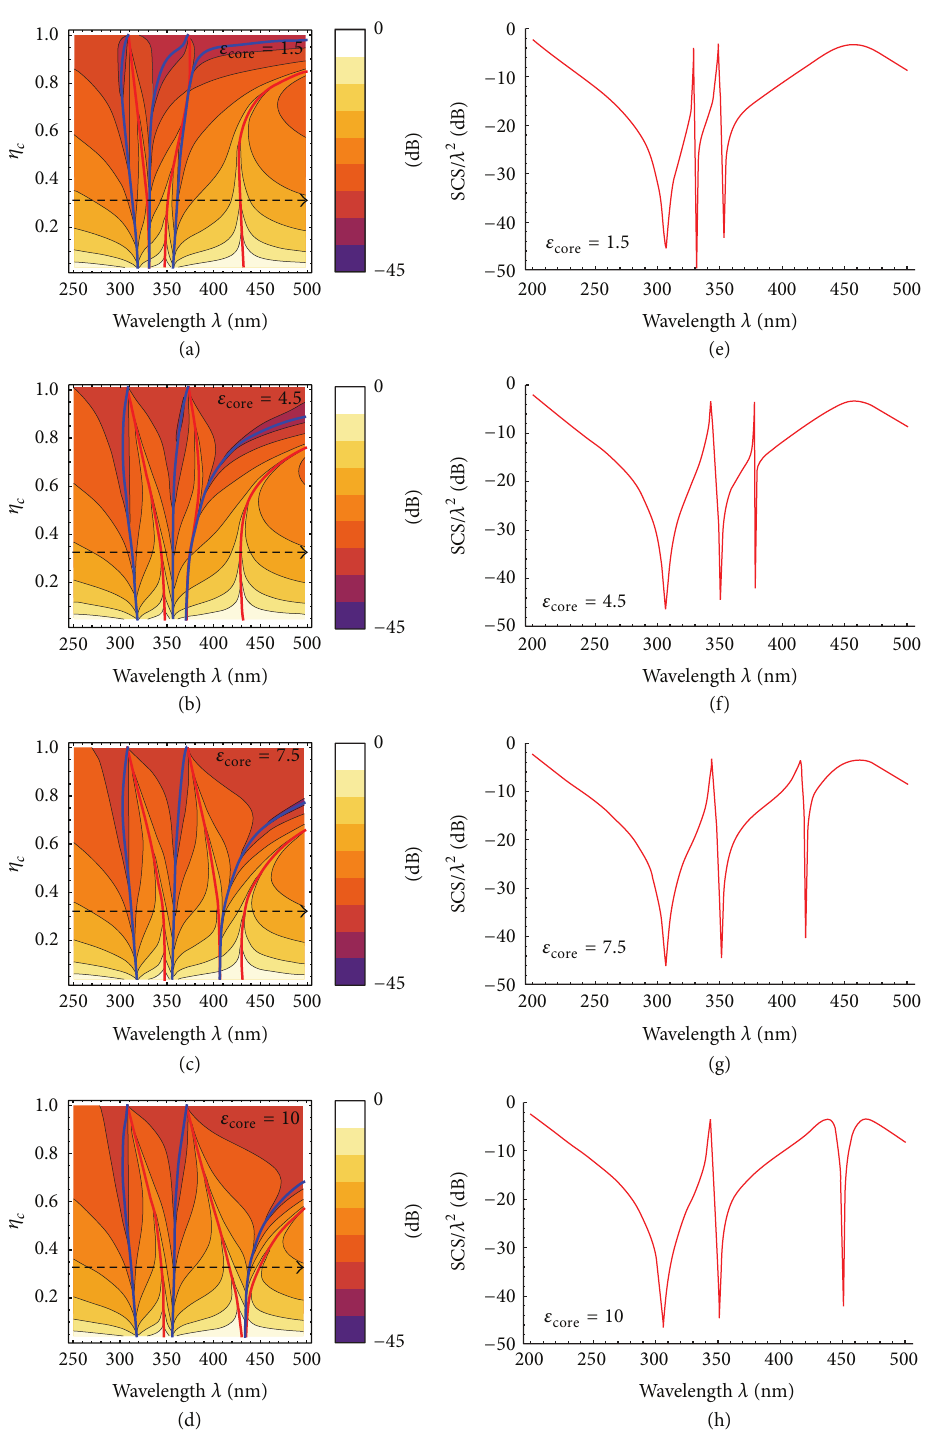
Figure 3: (a)–(d) Contour plots of the total SCS (normalized to the maximum value) as a function of the wavelength and the aspect ratio 𝜂 𝑐 and (e)–(h) normalized SCS /𝜆 2 versus wavelength, for different core permittivities of the structure in Figure 1(a): (a), (e) 𝜀 = 4.5 , (c), (g) 𝜀 = 7.5 , and (d), (h) 𝜀 = 10 . The aspect ratio is fixed to 𝜂 = 0.33 (indicated by the dashed arrow in panels (a)–(d)). 𝜀 𝑐 core core core Cloaking (blue lines) and resonant scattering (red lines) quasi-static conditions are also shown in the contour plots